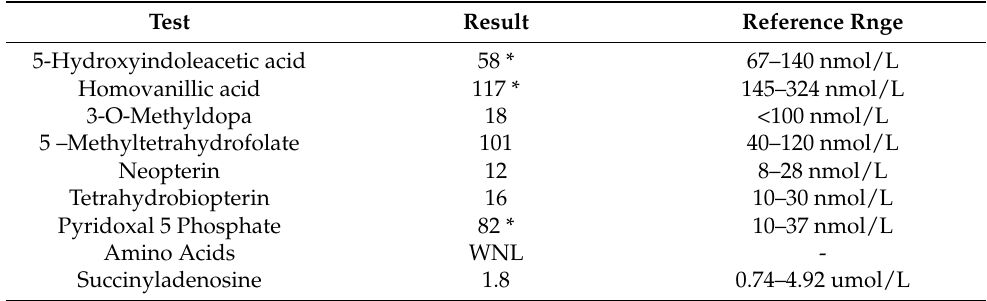
Table 1. Results of CSF metabolite analysis. * Abnormal results. WNL: Within normal limits.